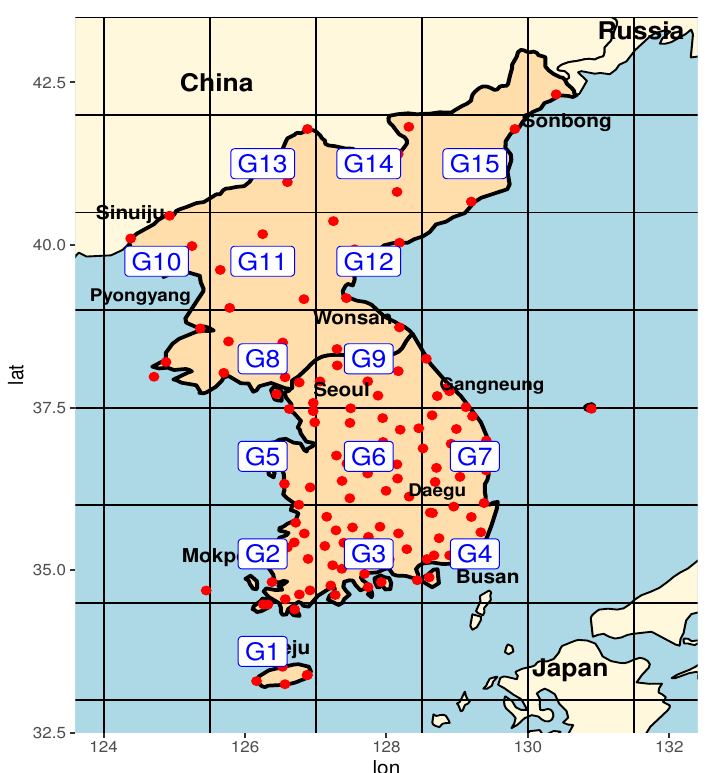
Figure 1. Map of the Korean peninsula, the spatial distribution of 127 rainfall observed stations, and 15 grid cells used in this